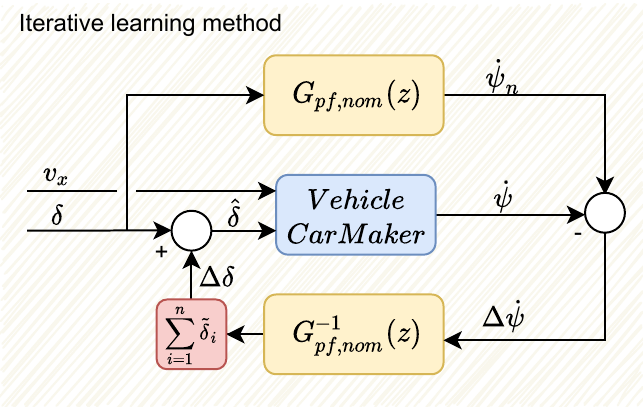
Figure 3. Structure of the data